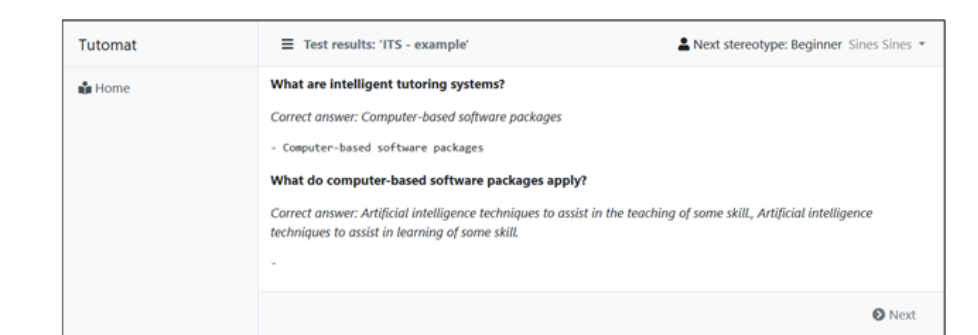
Fig. 2. The testing phase in the Tutomat.